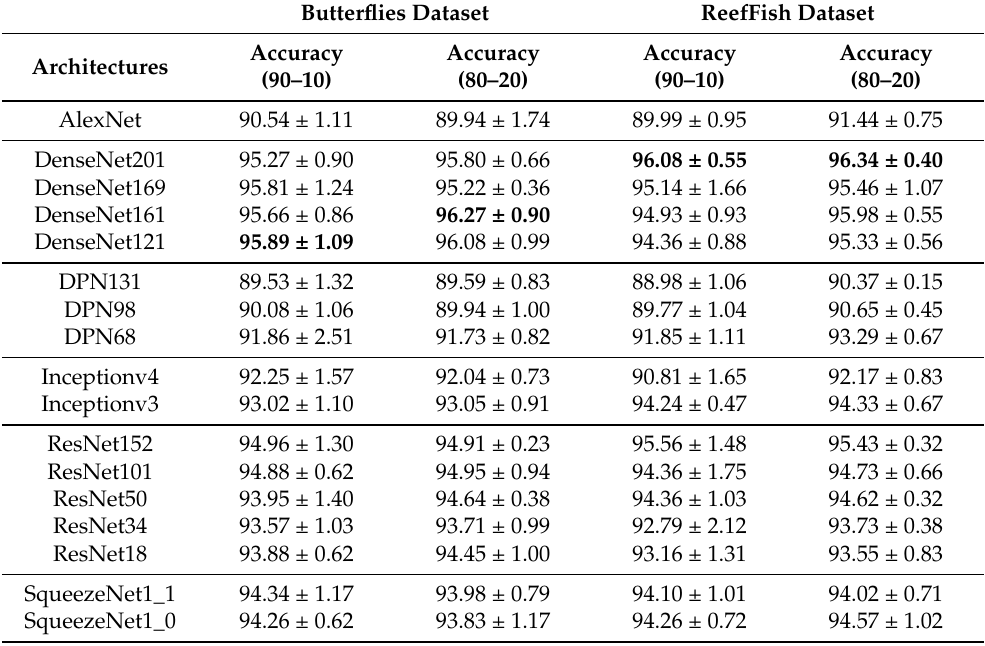
Table 3. Comparison of the CNN architectures, benchmarking the proposed datasets. Each experi- ment is performed five times. The standard deviation is provided with each model’s result, and the best ones are given in